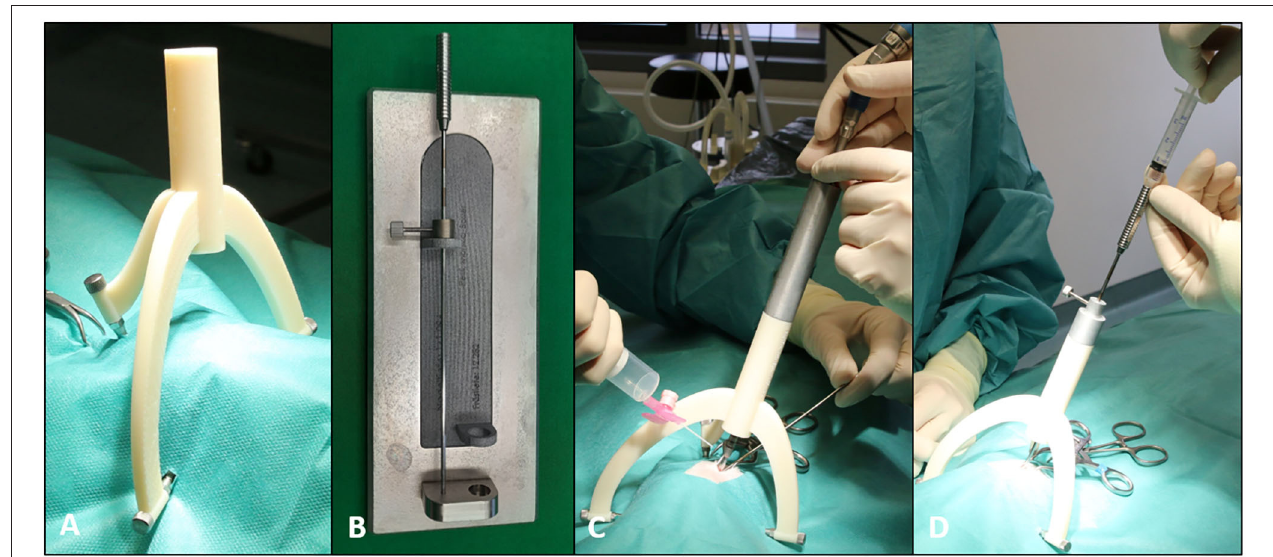
FIGURE 2 | A brain biopsy procedure with the MRI-based patient-individual brain biopsy device. (A) A 3D printed biopsy frame (consisting of three legs and a biopsy port) attached to the bone anchors by using specific screws. (B) Patient-individual 3D printed measuring instrument for adjustment of the desired depth of the brain biopsy needle with help of a spacer. (C) A biopsy frame with the drill sleeve in place during the creation of a 3mm mini burr hole for brain biopsy. (D) A brain biopsy needle placed in needle sleeve with an attached